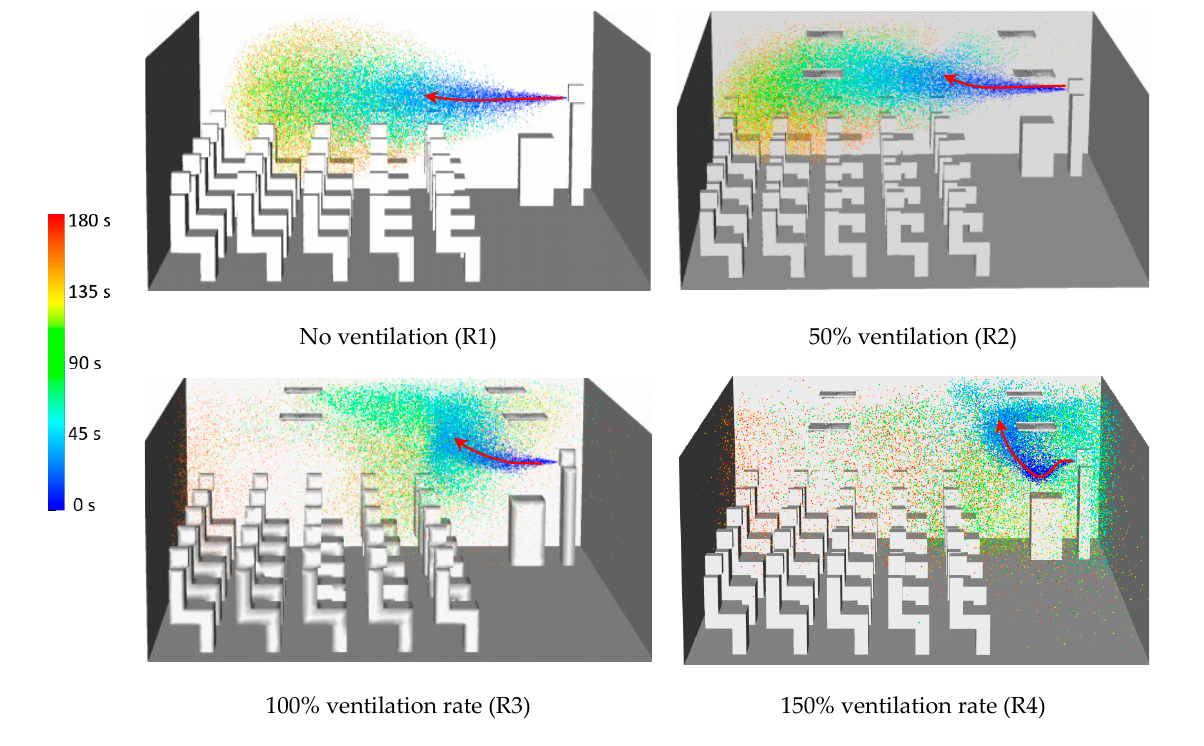
Figure 9. Time residence for dispersed aerosol droplets after 180 s.